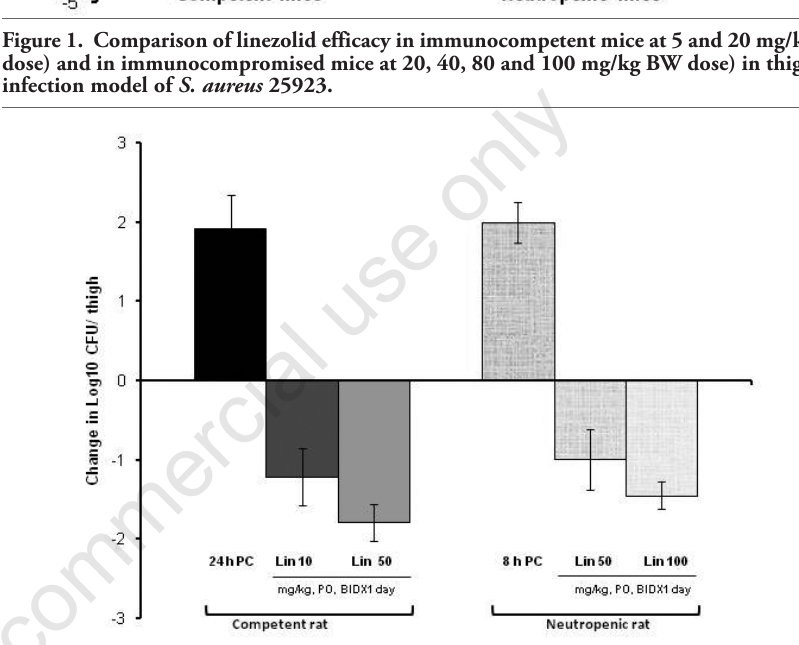
Figure 2. Comparison of linezolid efficacy in immunocompetent rat at 10 and 50 mg/kg dose) and in immunocompromised rat at 50 and 100 mg/kg BW dose) in thigh infection model of S. aureus